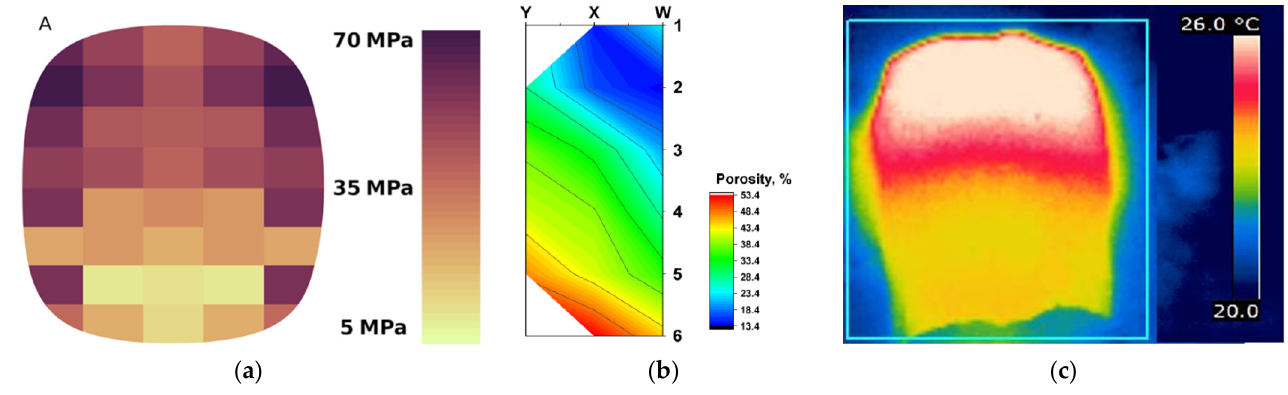
Figure 16. A general correlation between pressure distribution, porosity, and temperature distribution: ( a ) pressure distribution — DEM; ( b ) map of the porosity distribution on the copper briquette cross-section [53]; ( c ) the thermographic image of the briquette after briquetting [54].